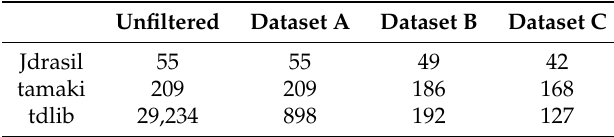
Table 2. Number of graphs, within each dataset, for which the given algorithm was fastest (see Sections 4.1 and